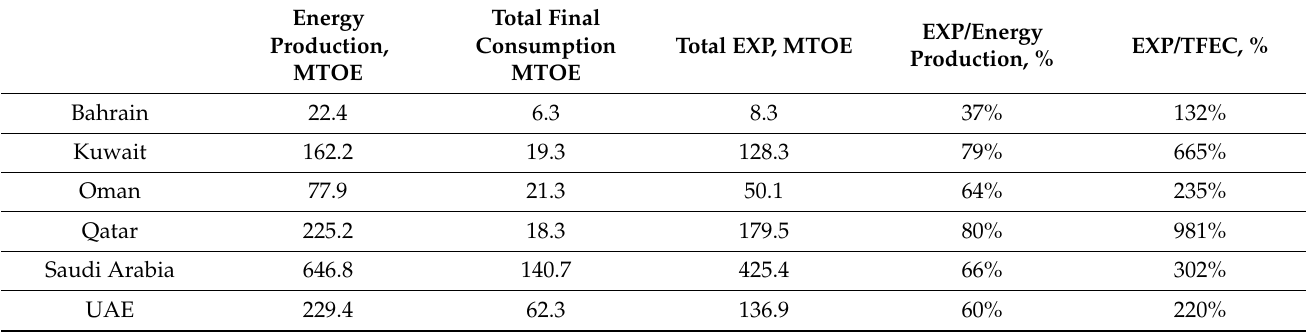
EXP/Energy Production, %